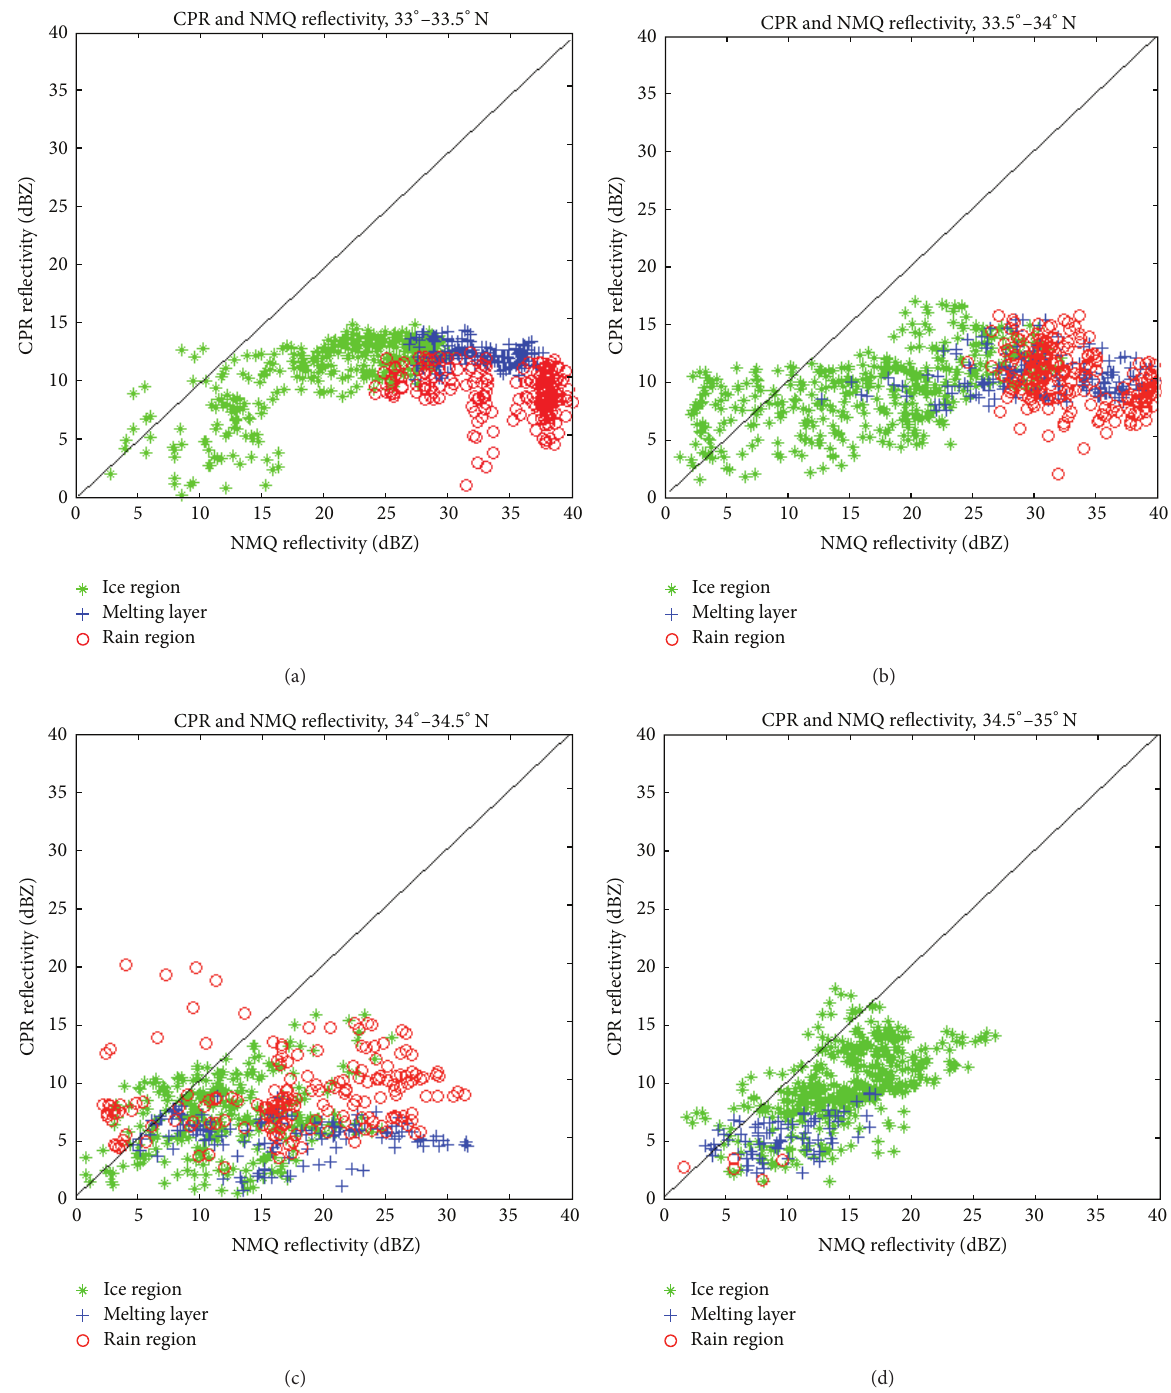
Figure 6: Scatterplots of NMQ reflectivity values and CPR reflectivity values from (a) 33 ∘ –33.5 ∘ N, (b) 33.5 ∘ –34 ∘ N, (c) 34 ∘ –34.5 ∘ N, and (d) 34.5 ∘ –35 ∘ N. The diamonds indicate the ice region, the crosses indicate the melting layer, and the circles indicate the rain region.